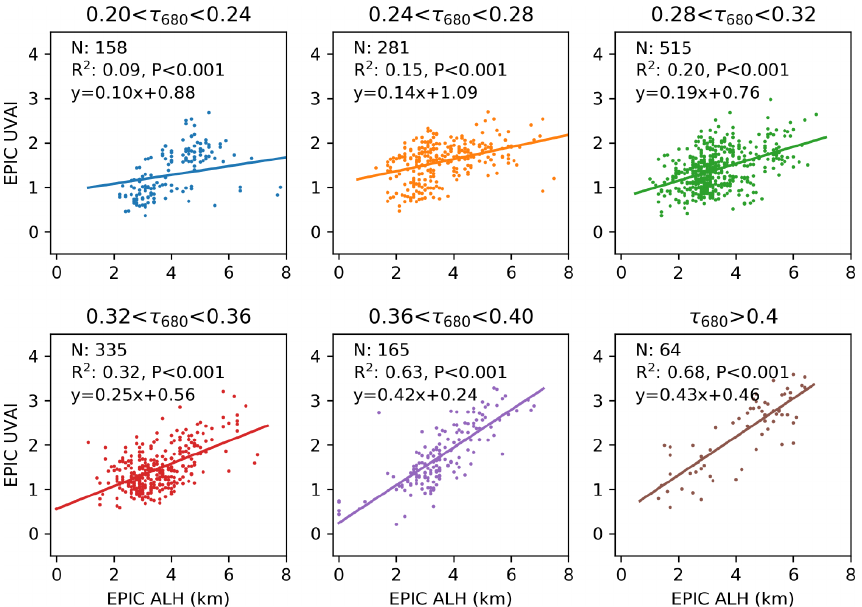
Figure 12. Scatterplots of EPIC UVAI (Fig. 11) versus current retrievals of ALH (Fig. 7) on 25 August 2017 (17:26UTC) under different AOD values as indicated in the title of each panel. Also annotated are the linear regression fit, number of scatter points ( N ), coefficient of determination ( R 2 ), and significance level ( P